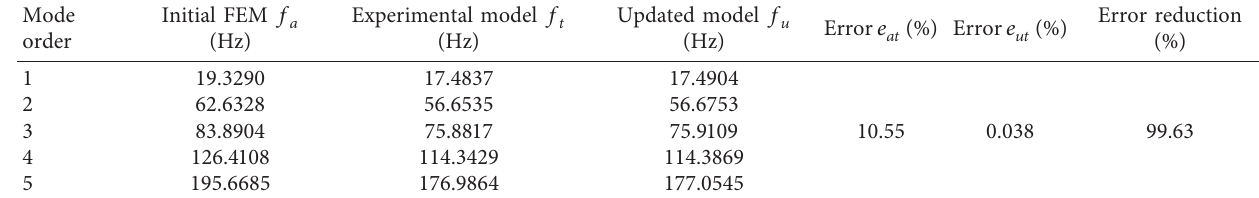
Table 6: Natural frequencies of the FEM, experimental, and updated